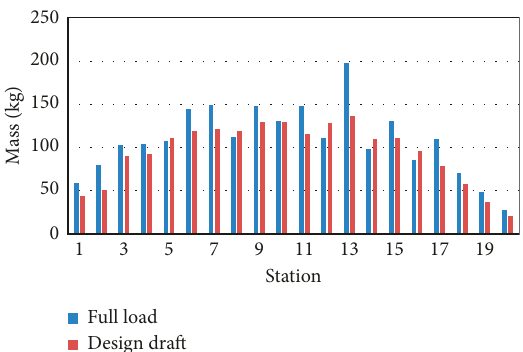
Figure 4: Weight distribution of the ship model.